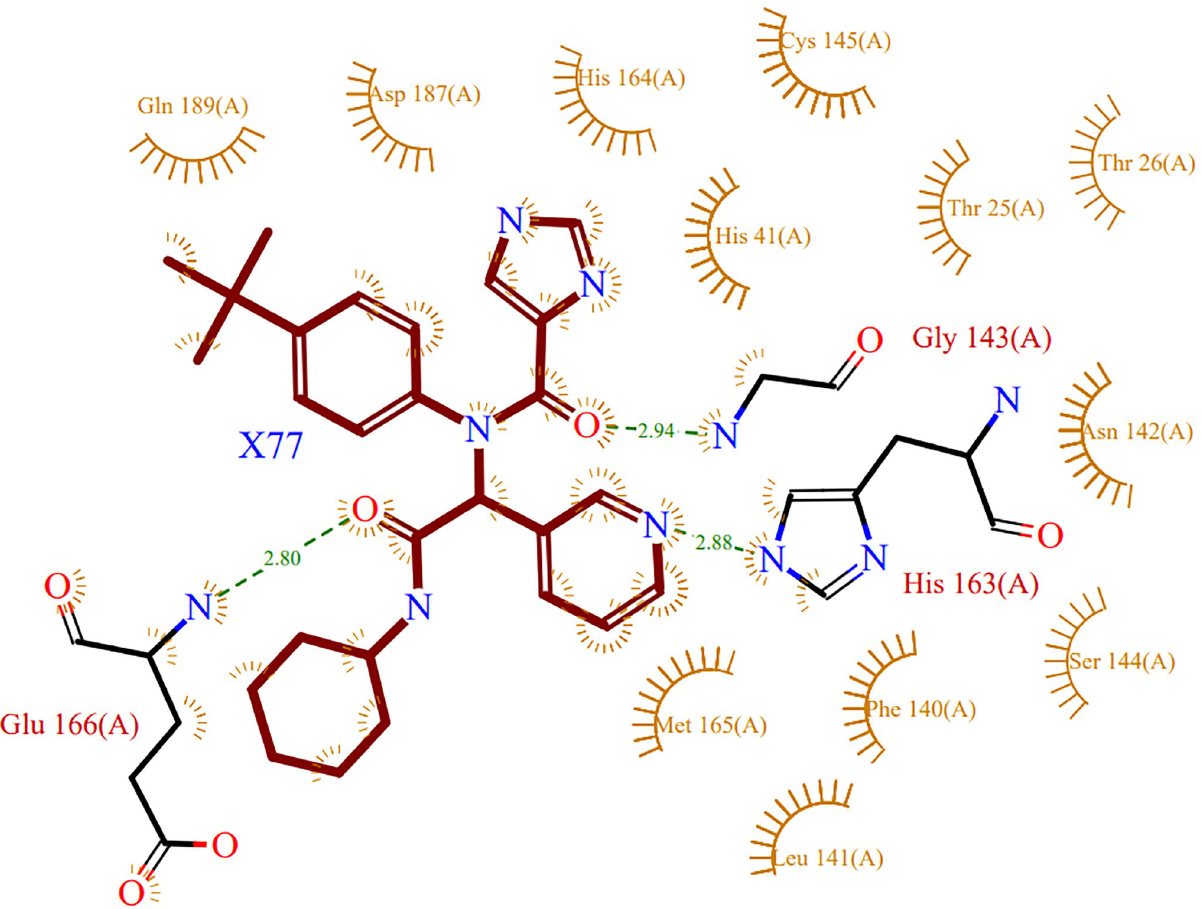
Fig 2. Native ligand (X77)-protein (PDB structure 6W63) 2D interactions plot: Representation of intermolecular interaction between native ligand and the active site amino acid residue of the target protein.